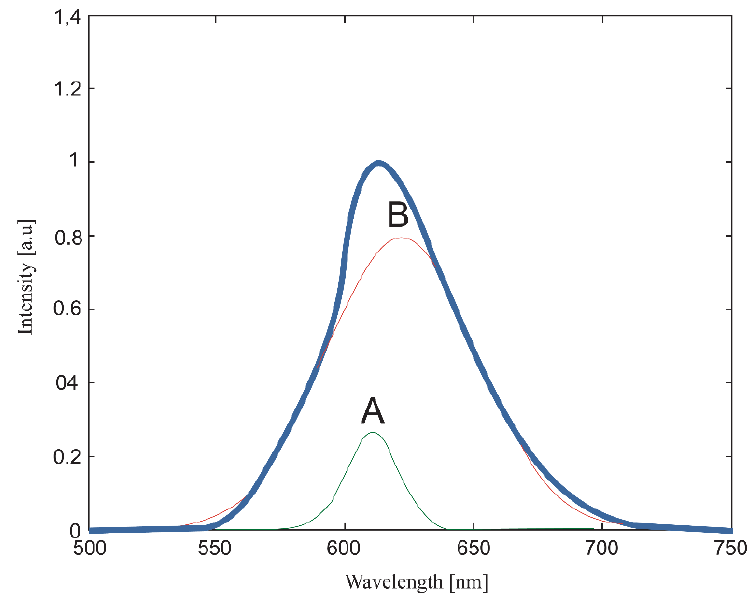
Figure 6. Photoluminescence bands of ZnSe doped with Eu 3+ . A, B are the emission bands, the blue line represents the sum of bands A and B Table 4. Temperature dependence of the bands for ZnSe:Eu 3+ .